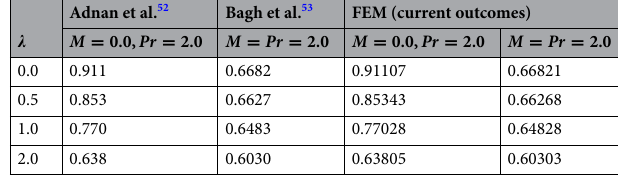
1 when others physical involved parameters are